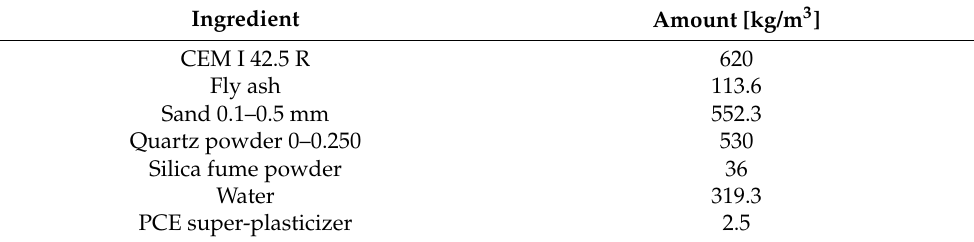
Table 2. Mixture design of the concrete mix used in this work, based on [30].